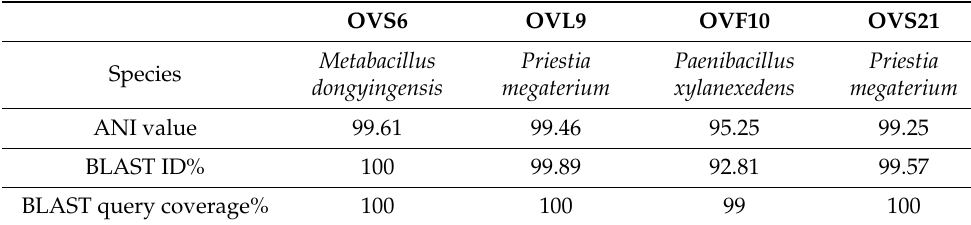
Table 2. Identity values for each endophytic strain.